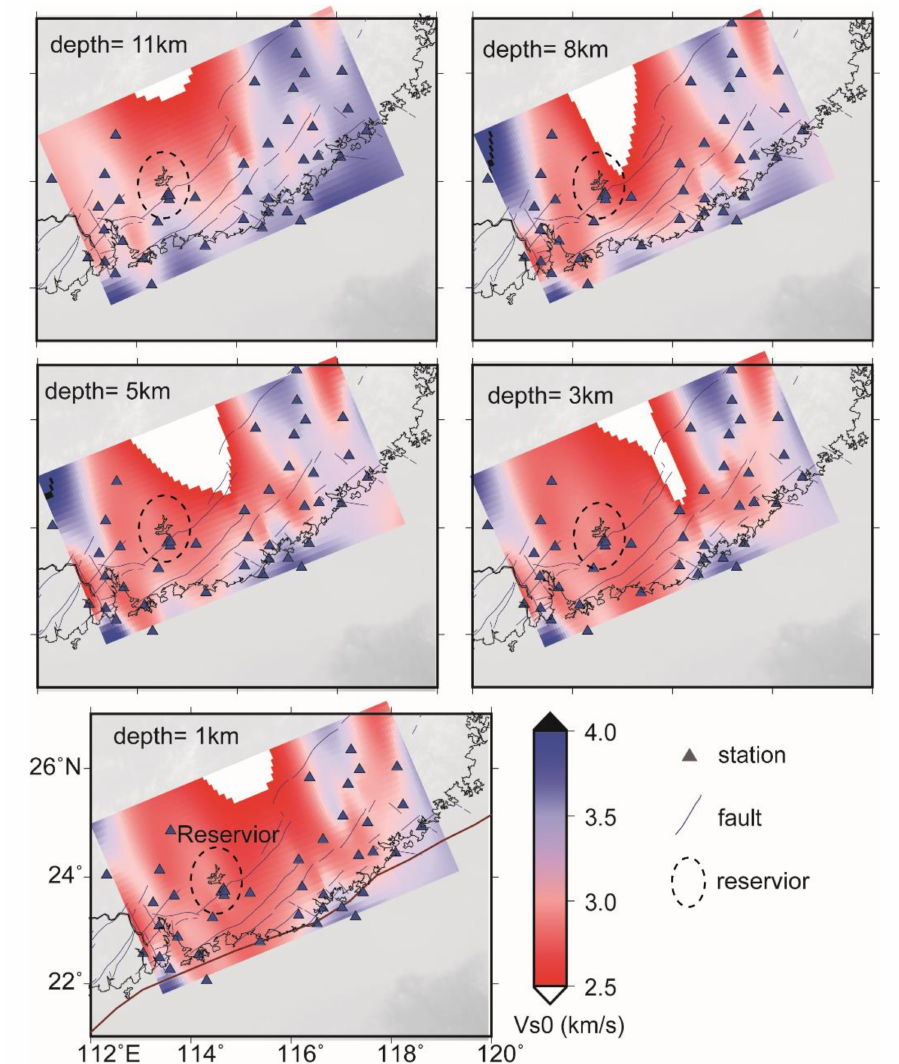
Figure 6. SWV tomographic structure in the XFJR and its adjacent area. The depth range of 11 to 1 km corresponds to alpha values of 0.5 to